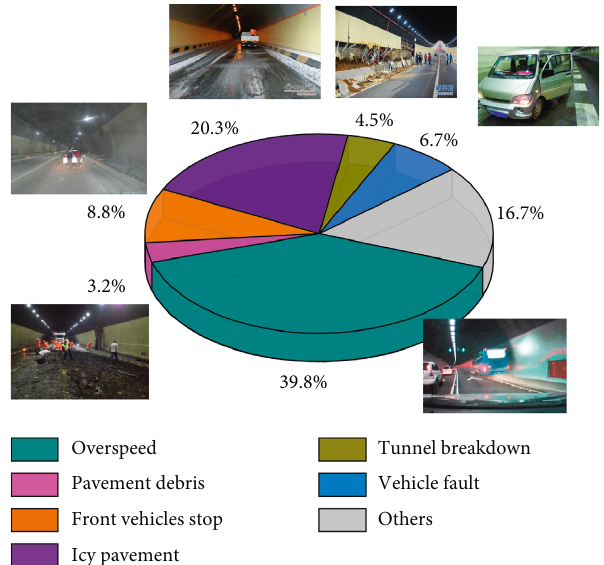
Figure 2: Reasons for traffic accidents in expressway tunnels.